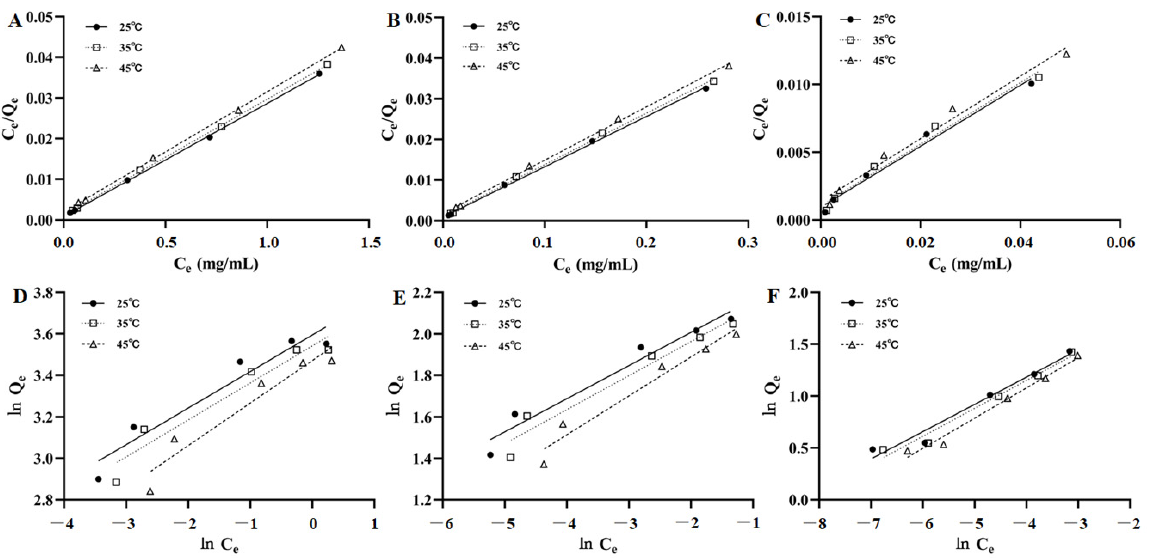
Figure 4. Langmuir models of AST ( A ), ISO ( B ), and ENG ( C ); Freundlich models of AST ( D ), ISO ( E ), and ENG ( F ). Table 2. Langmuir and Freundlich adsorption parameters of AST, ISO, and ENG on HPD-300 resin.